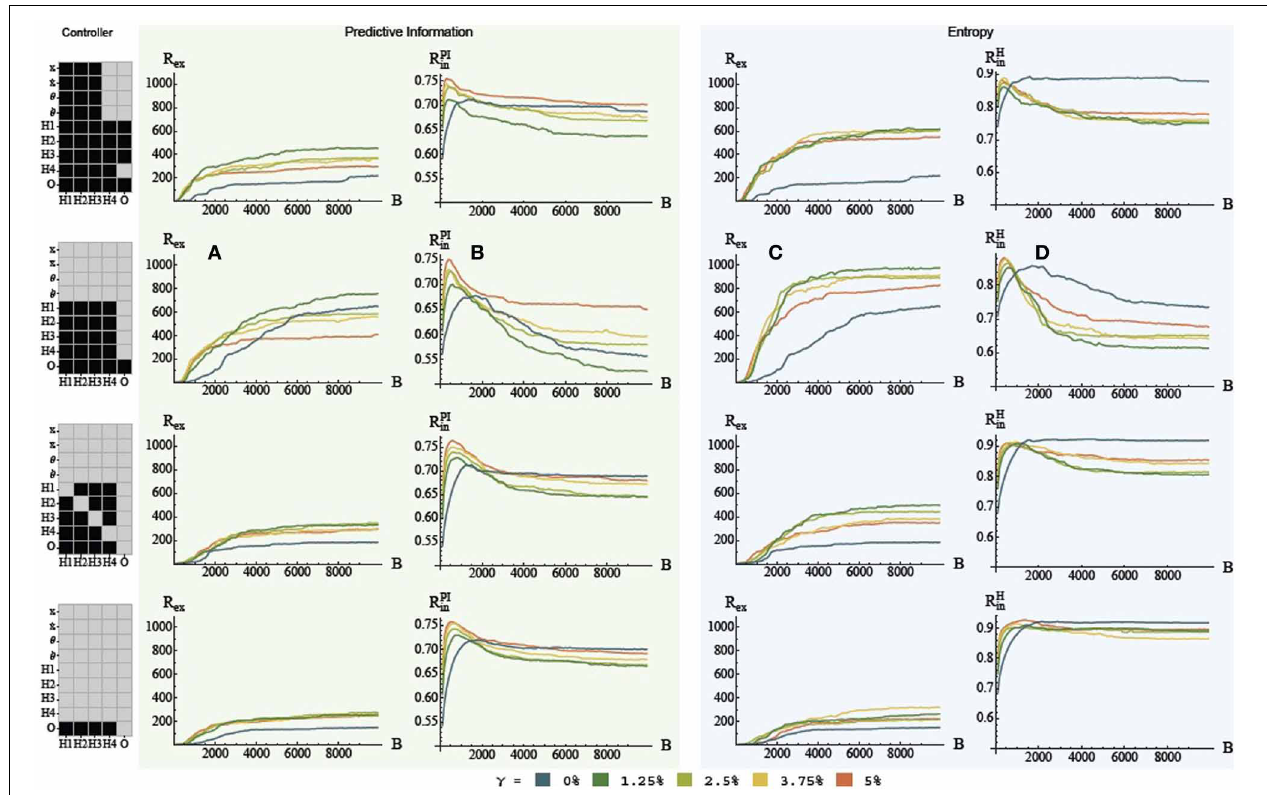
for the second controller is discussed in detail. (A,B) ERF and IRF for PI maximization—small values of γ > 0 are advantageous.